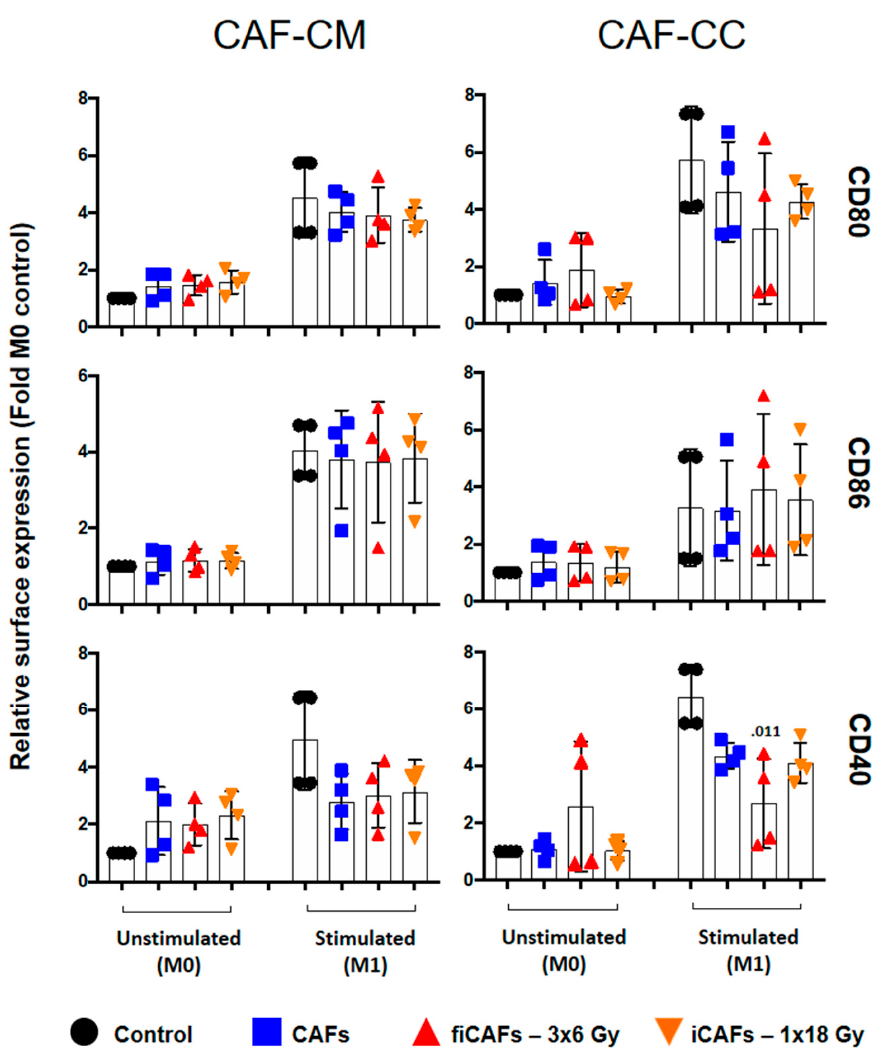
Figure 2. E ff ects of CAFs on M1-macrophage cell surface markers. Monocyte-derived macrophages in non-stimulated or stimulated conditions were incubated with conditioned medium from irradiated (iCAF-CM) or non-irradiated CAFs (CAF-CM) or in (macrophage-CAF) co-cultures (CC). Resulting surface expression of M1-macrophage cell surface markers CD80, CD86 and CD40 were evaluated by flow cytometry. Filled black circles indicate surface levels in control macrophage cultures (M0 and M1). Results are expressed as fold M0-controls. Data represent mean ( ± SD) values from four-4 di ff erent CAF donors measured independently. Non-parametric Kruskal-Wallis test and p -values were determined between control and non-irradiated CAFs, control and the two iCAF-groups individually. iCAF (irradiated CAFs); fiCAFs: fractionated-irradiated